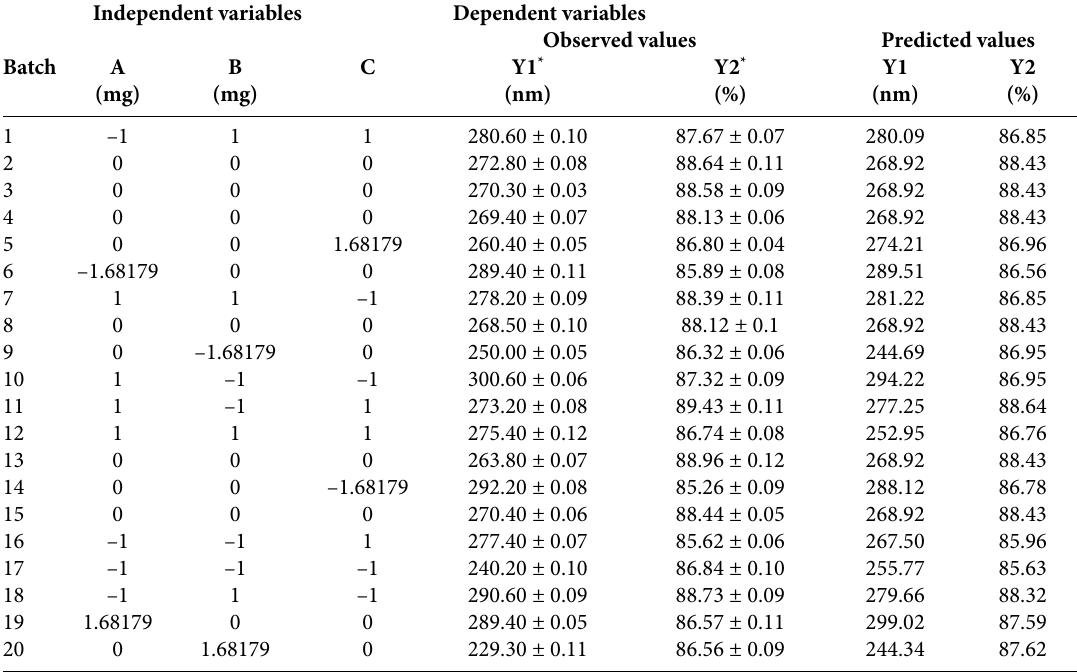
Table 5 . CCD matrix with predicted and observed values of responses Independent variables Dependent variables